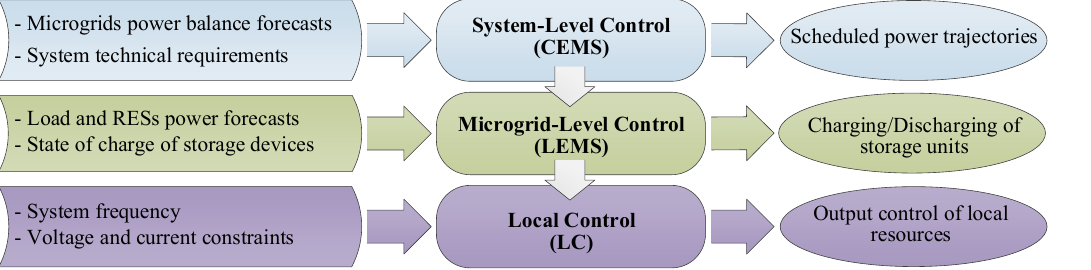
Figure 1. Proposed hierarchical control